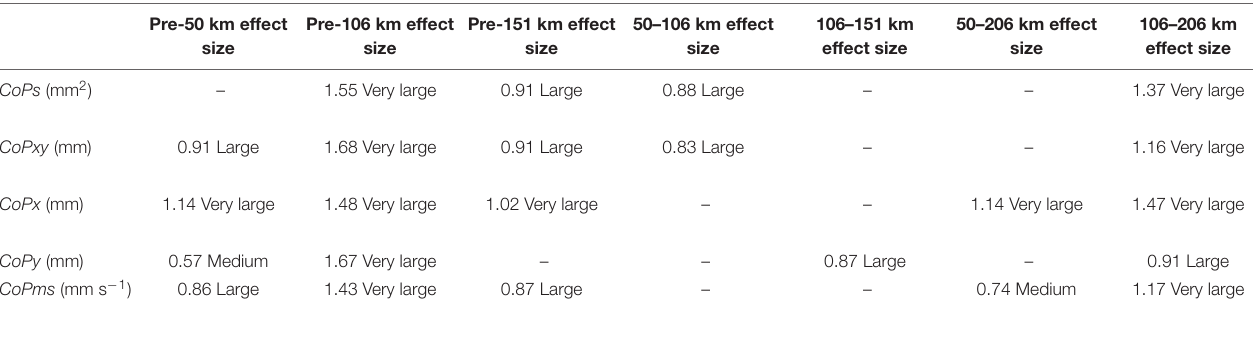
TABLE 1B | Effect size of classical PC